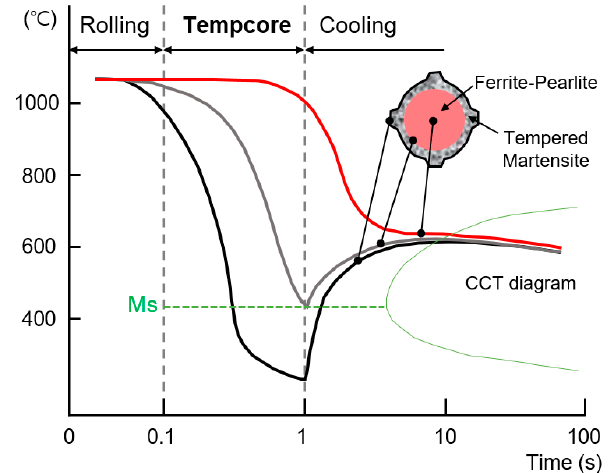
Figure 1. Schematic of temperature profile and microstructural evolution in Tempcore treated rebars.